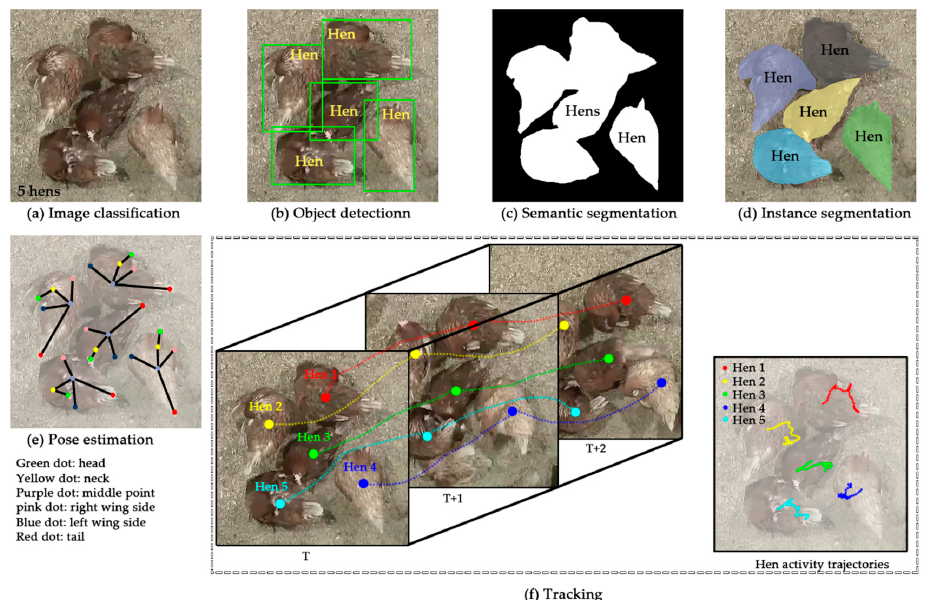
Figure 3. Example illustrations of six computer vision tasks. The semantic and instance segmentations were combined as semantic/instance segmentation due to many similarities, resulting in the major five computer vision tasks throughout the study.